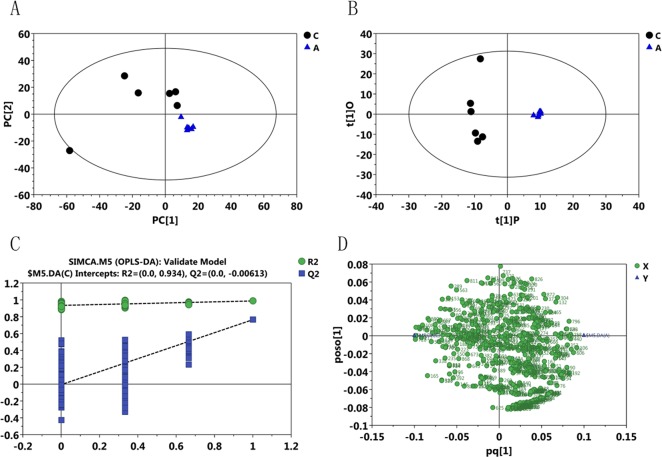
The multivariate data analysis among the C and A group (27°C vs 16°C).A, the scatter plot of the PCA model. B, The OPLS-DA model in order to identify the metabolites that differed significantly between the two groups. C, 200-permutation test was further applied to validate the OPLS-DA model, confirming the robustness of the model. D, loading plot based on the OPLS-DA model, and the metabolites located in the marginal area were potential discrepant metabolites.